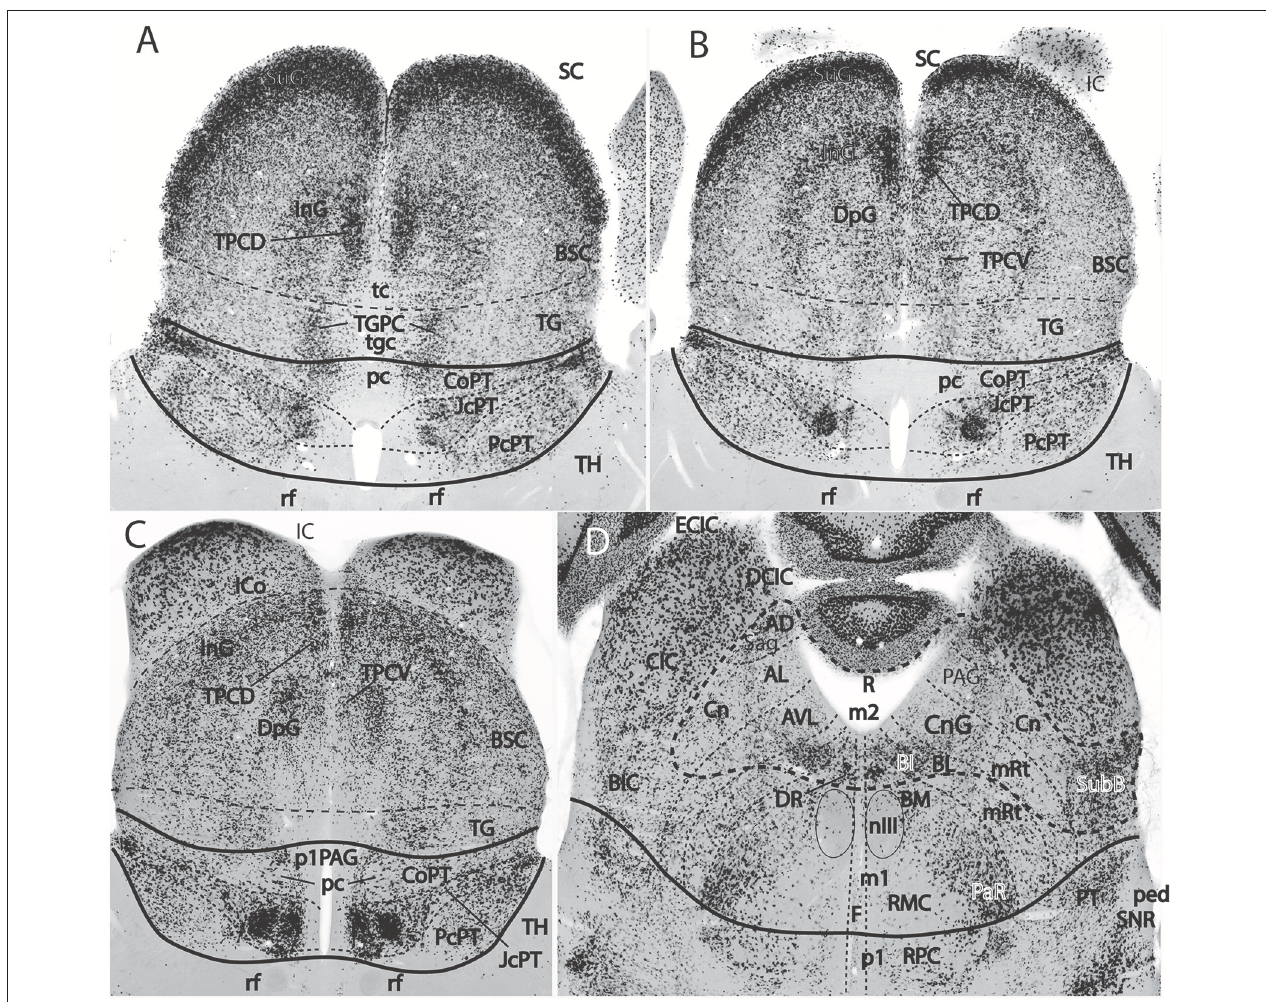
FIGURE 9 | Figure extracted from Puelles E. et al. (2012a) showing fundamental pretectal and midbrain structure in four horizontal sections (A–D) in dorsoventral order, illustrating in particular the adult mouse thalamo-pretectal and pretecto-mesencephalic boundaries (thick black lines; no copyright permission required). This material is in situ reacted for Gad67, thus showing selectively midbrain alar GABAergic neurons in superficial, intermediate and deep periaqueductal strata (note there are practically none within the neighboring thalamus). The pretecto-mesencephalic border passes just behind the posterior commissure and in front of the distinct superficial, layered and retinorecipient formation identified as tectal gray (pc; TG; A–C ). The TG differs from the superior colliculus (SC) in the number of superficial GABAergic neurons, as well as in the aspect of its periaqueductal formation. The novel dorsomedial tectal elements termed dorsal and ventral tectal paracommissural (longitudinal) nuclei are shown in position (TPCD, TPCV; A–C ); there is also a similar tectal gray paracommissural nucleus (TGPC; A ). The pretectum appears divided into precommissural (PcPT), juxtacommissural (JcPT), and commissural (CoPT) anteroposterior domains with differential structure and molecular profile ( A–C ; Ferran et al., 2008, 2009). The inferior colliculus (IC) starts to appear in (B , C) , but is shown fully in (D) . The section in (D) is slightly oblique from left to right, so that the right side passes somewhat under the IC, showing slightly more of the caudally underlying preisthmus or m2-derived midbrain territory (formations enclosed by the thick dash line; note the relevant subpial subbrachial nucleus, SubB, at the right). The small dash lines in (D) refer to the limits between different dorsoventral midbrain sectors visible at this level. Neither the oculomotor nucleus (nIII) nor the magnocellular nucleus ruber (RMC) in the basal plate contain GABAergic neurons, but the latter is surrounded laterally by a distinct mass of such cells, forming the pararubral nucleus [PaR; (D) ; this population derives from the parabasal Nkx2.2 -positive band illustrated in chicken in Figure 5C , and expresses this marker in the adult]. GABAergic cells are also present as a subpopulation in the parvocellular nucleus ruber lying in the pretectal tegmentum, also partly surrounded by the PaR (RPC, D ).